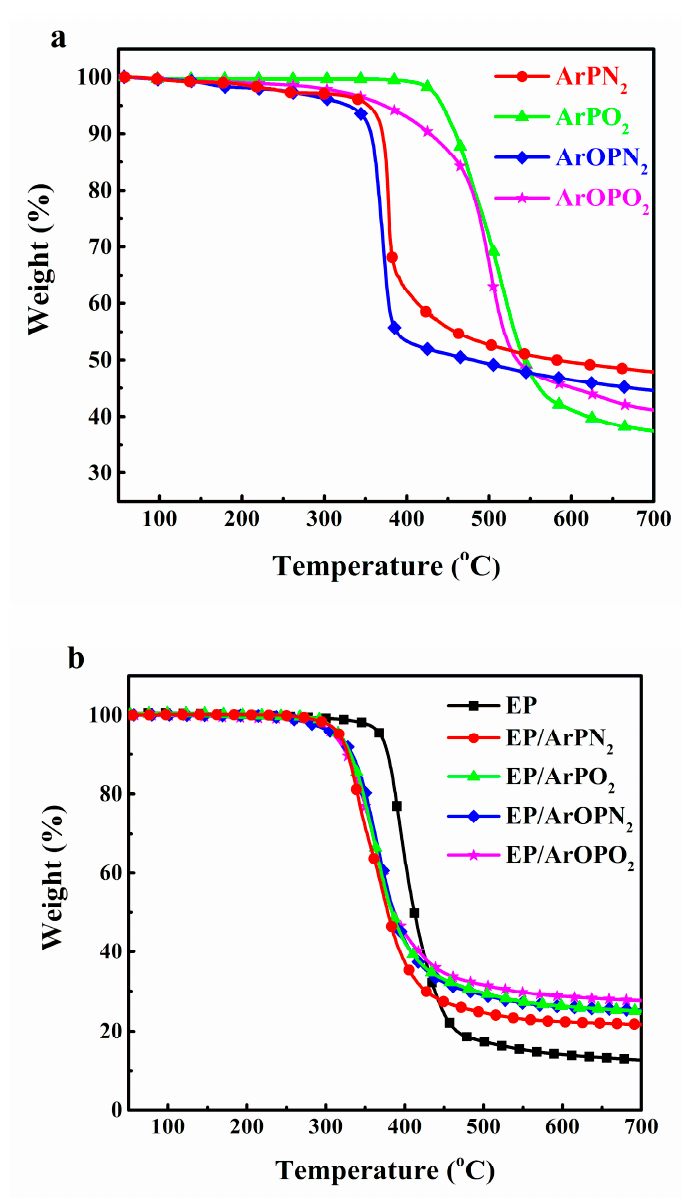
Figure 3. Thermogravimetric analysis (TGA) curves of polysulfone ( a ) as well as EP and EP/polysulfone composites ( b ).